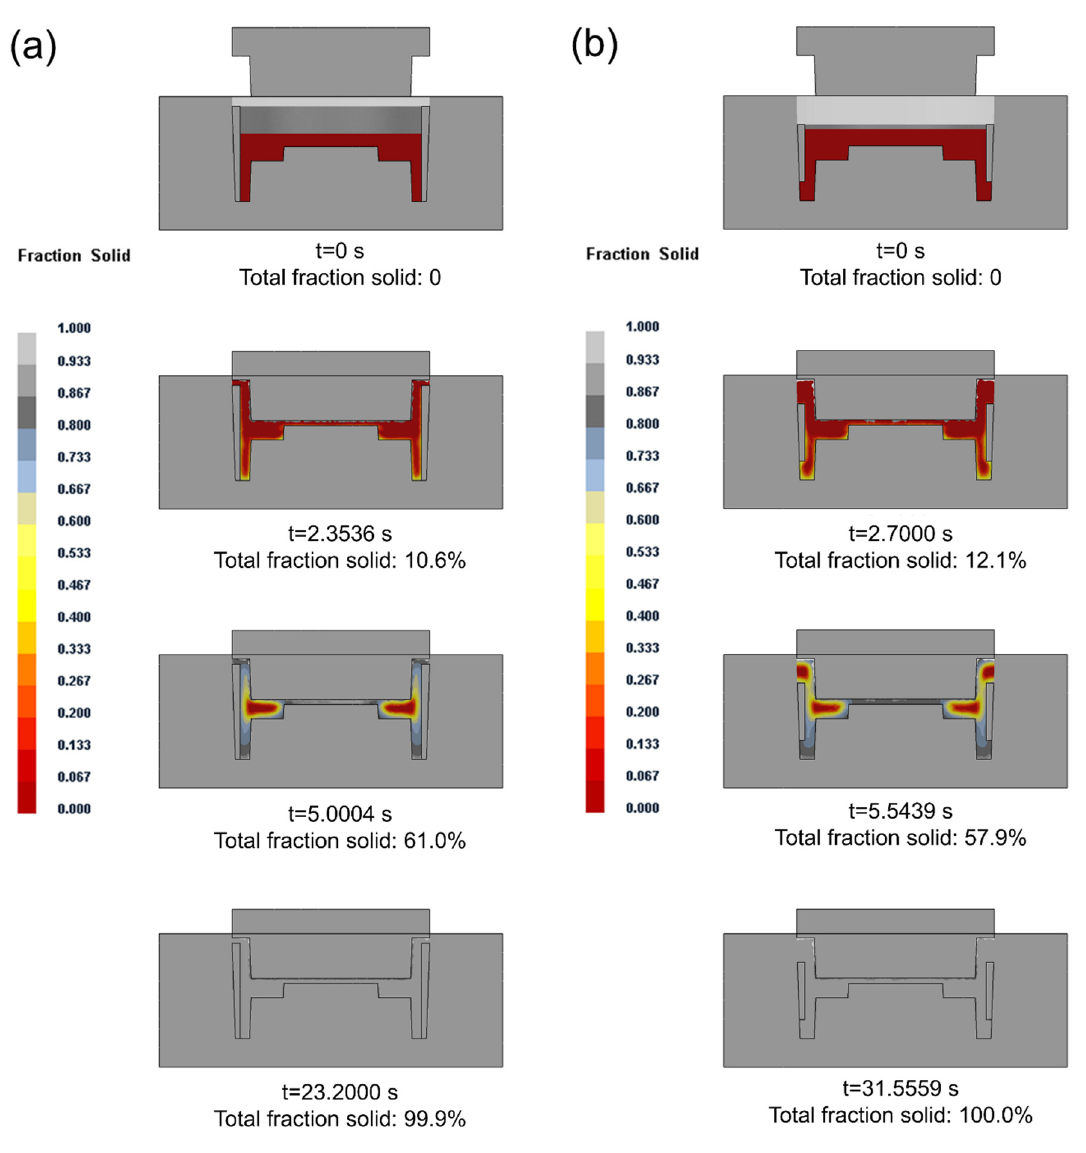
Figure 9. Change of solid fraction in the compound casting process of long ring ( a ) and short ring ( b ). The temperature–time curve of the inner surface of the composite ring is shown in Figure 10. The three observation points 1, 2 and 3 correspond to the positions of the top, middle and bottom of the inner surface of the composite ring respectively, as shown in Figure 5. The temperature of the middle part of the long ring increased the